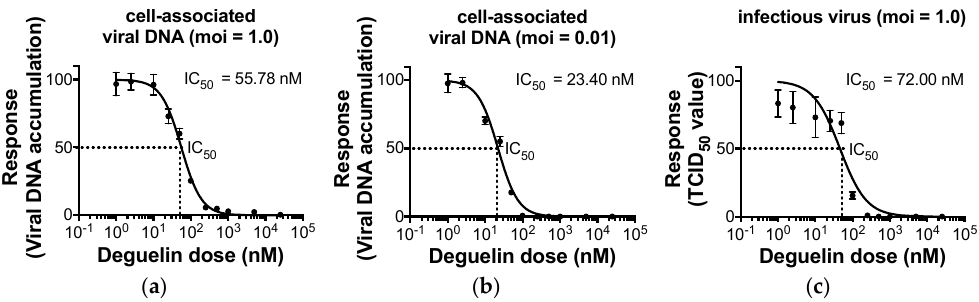
Figure 2. Deguelin suppresses HCMV replication in infected fibroblasts. NuFF-1 cells were infected with UL99 eGFP in the presence of vehicle (DMSO) or deguelin at either ( a ) a high multiplicity (moi = 1.0) for 7 d, or ( b ) a low multiplicity (moi = 0.01) for 14 d. Cell-associated DNA was harvested from the respective cultures and analyzed by qPCR using primers directed at UL122. Samples were analyzed in triplicate and normalized to cellular MDM2. ( c ) NuFF-1 cells were infected as in ( a ), and at 7 dpi, the cell-free virus was harvested and viral titers were analyzed by TCID 50 . For all panels, error bars represent the standard deviation of three technical replicates. Replicate assays were performed ( n = 3), and a representative biological replicate is shown in each panel.